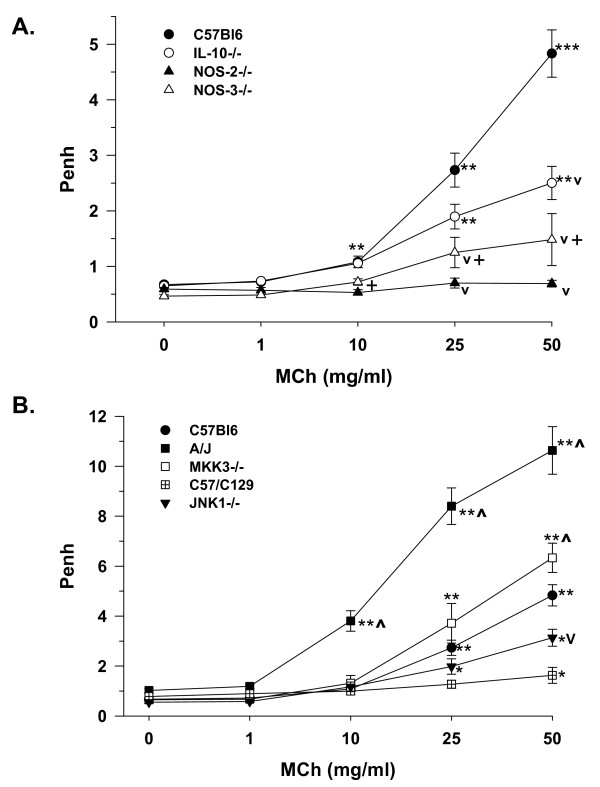
Airway responses to MCh (as enhanced pause; Penh) in naïve mice of various strains. A. Means ± SE shown for strains C57Bl6 (filled circle, n = 12), IL-10-/- (open circle, n = 12), NOS-2-/- (filled triangle, n = 8) and NOS-3-/- (open triangle, n = 4); **P < 0.05 vs. 0 mg/ml MCh and next lowest MCh concentration within strain; ***P < 0.05 vs. 0 mg/ml MCh and next two lowest MCh concentrations within strain; vP < 0.05 decreased vs. C57Bl6 at same MCh concentration; +P < 0.05 NOS-2-/- vs. NOS-3-/- at given MCh concentration. B. Means ± SE shown for strains: A/J (filled square, n = 12), MKK3-/- (open square, n = 10), MKK3-sufficient C57/C129 (crossed square, n = 10), JNK1-/- (inverted filled triangle, n = 10), as compared to C57Bl6, as in panel A. *P < 0.05 as compared to 0 mg/ml MCh within strain; ^P <0.05 increased vs. C57Bl6 at same MCh concentration; other significance symbols as in panel A.